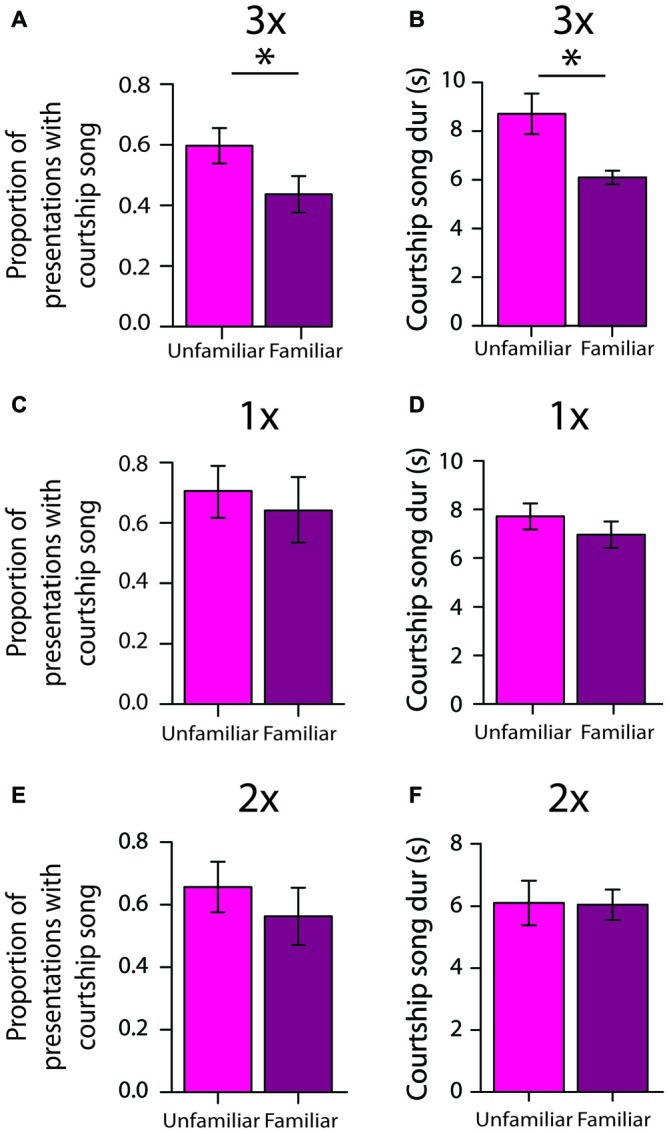
Repeated exposures to females are important for the persistence of social memories over days (longer-term memory tests). (A) When tested 2 days after 3X tests, male Bengalese finches were significantly less likely to produce courtship song to familiar females than to unfamiliar females (n = 13 males; Table 2). Plotted are the average (±SEM) proportions of presentations with courtship song. (B) Two days after 3X tests, males produced shorter courtship songs to familiar females than to unfamiliar females (n = 7 males; i.e., only males that produced at least three courtship songs to familiar females and at least three courtship songs to unfamiliar females). (C) Two days after 1X tests, males did not differentially produce courtship song to unfamiliar and familiar females (n = 7 males). (D) Two days after 1X tests, males produced courtship songs to familiar and to unfamiliar females that were of similar duration (n = 6 males; i.e., only males that produced at least three courtship songs to familiar females and at least three courtship songs to unfamiliar females). (E) Two days after 2X tests, males did not differentially produce courtship song to unfamiliar and familiar females (n = 10 males). (F) Two days after 2X tests, males produced courtship songs to familiar and to unfamiliar females that were of similar duration (n = 8 males; i.e., only males that produced at least three courtship songs to familiar females and at least three courtship songs to unfamiliar females). For all panels, “*” indicates p < 0.05.